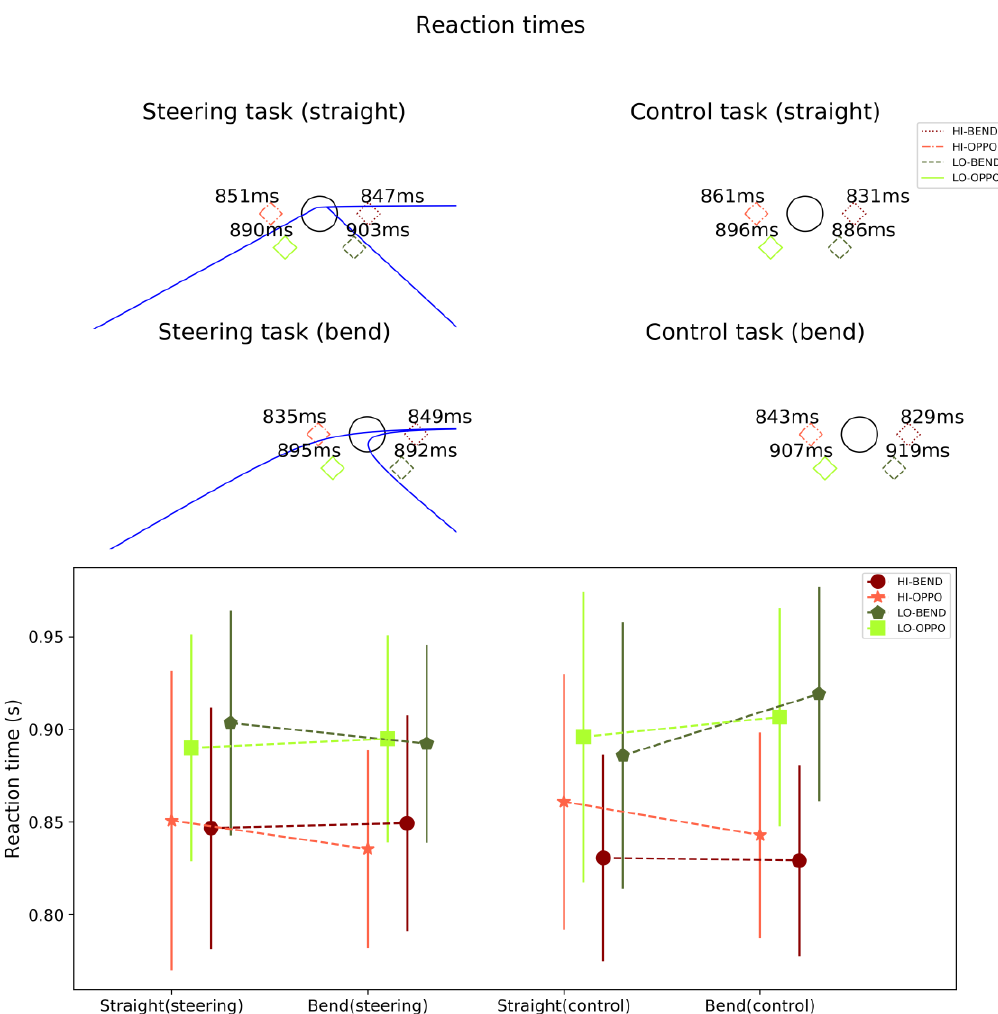
Figure 8. Top . Mean reaction times for targets presented in the different target locations, in the steering and control tasks and on the straights and in the bends. Bottom. The mean reaction times and standard deviations in a line